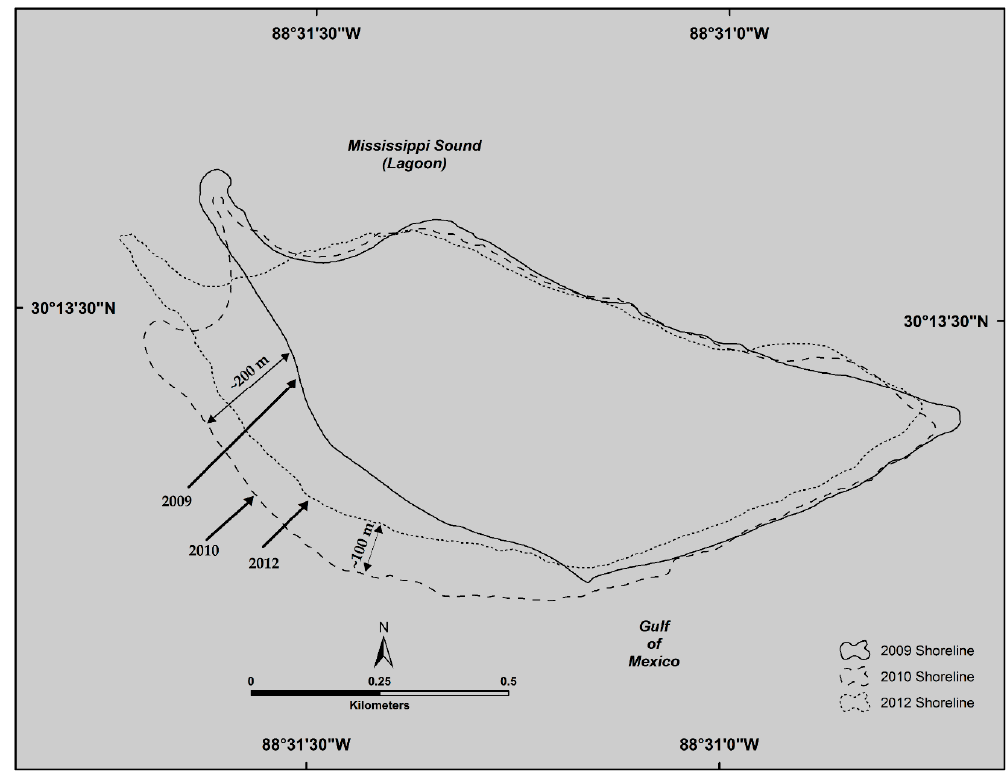
Figure 8. Map showing Sand Island shoreline change from deposition of dredge material (2009–2010) and Hurricane Isaac (2012). Shorelines are represented by a solid line for 2009 (pre-deposition), large dashed line for 2010 (post-deposition, pre-Isaac) and a small dashed line for 2012